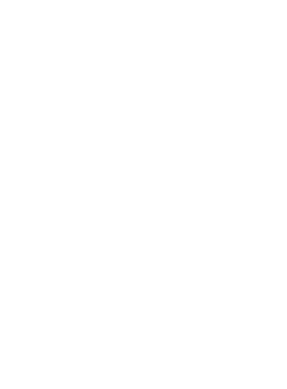
Figure 1. “Charging an anomaly battery" – The anomaly-inflow picture of a chromoelectric flux tube in the QCD vacuum — The black circle and the white circle represent color sources (e.g. a quark-antiquark pair) and the lines between them are chromoelectric field lines squeezed into a thin tube in the vacuum (shaded area). The arrows on the circle indicate the directions of the induced vacuum current on a particular cross-section of the flux tube, similar to the configuration of the Hall e ff ect